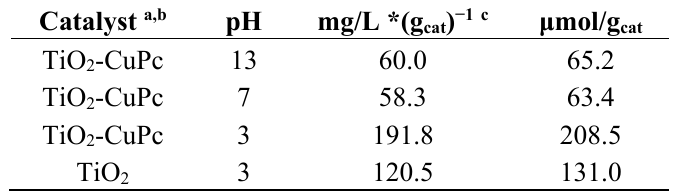
Table 2. Effect of initial pH on the production efficiency of formic